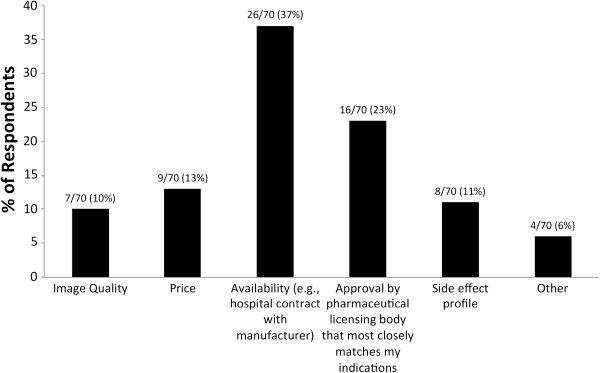
 Rationale for use of particular GBCA. 37% of respondents indicated “availability (e.g. hospital contract with manufacturer)” as the most important reason, followed by “approval by pharmaceutical licensing body that most closely matches my indications” (23%). Less important reasons for particular GBCA use are “price” (13%), “side effect profile” (11%), “image quality” (10%), and “other” (6%).